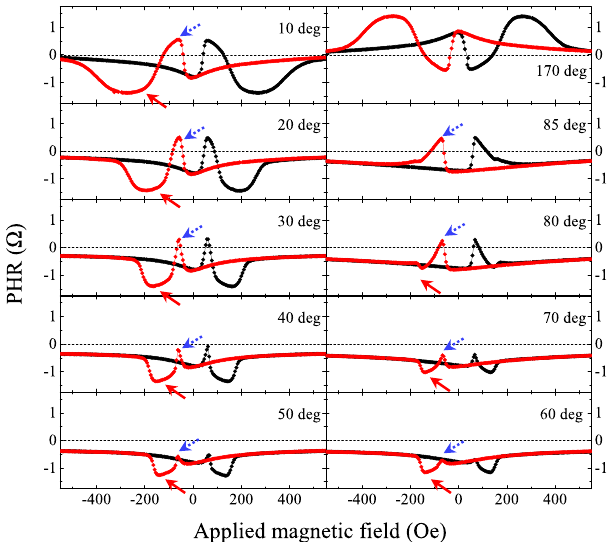
Figure 3. Planar Hall resistance obtained for sample T2 at 3 K. The field orientation was changed from ϕ = ° 10 to ϕ = ° 85 in successive panels. PHR data obtained at 170° is plotted at the top of the right column H H for comparison with the data obtained at 10° in the top panel of left